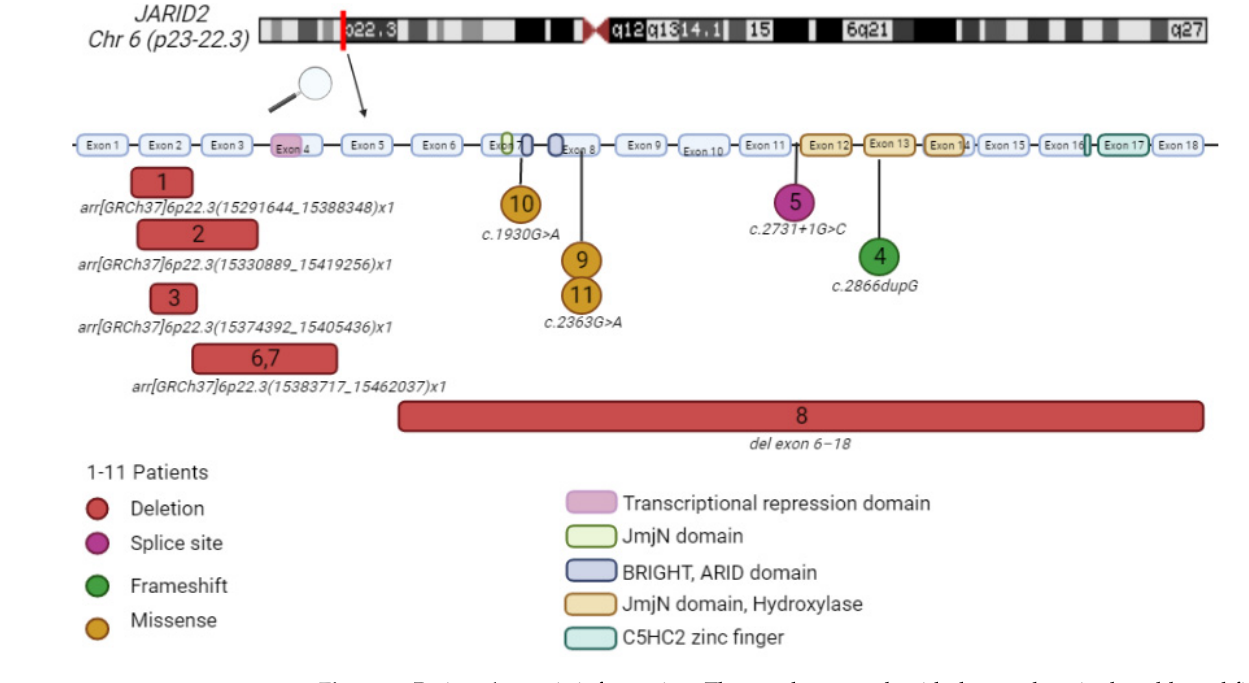
Figure 1. Patients’ genetic information. The numbers match with the numbers in the table and figures. Comparison between the patients with deletions (red square), splice site (purple circle), frameshift (green circle) and missense (yellow circle) variants. Patients 6 and 7 have the same deletion and are related (mother and daughter). Patient 9 and 11 are not related to each other. Alamut Visual version NM_004973.4 JARID2 . Created with BioRender.com